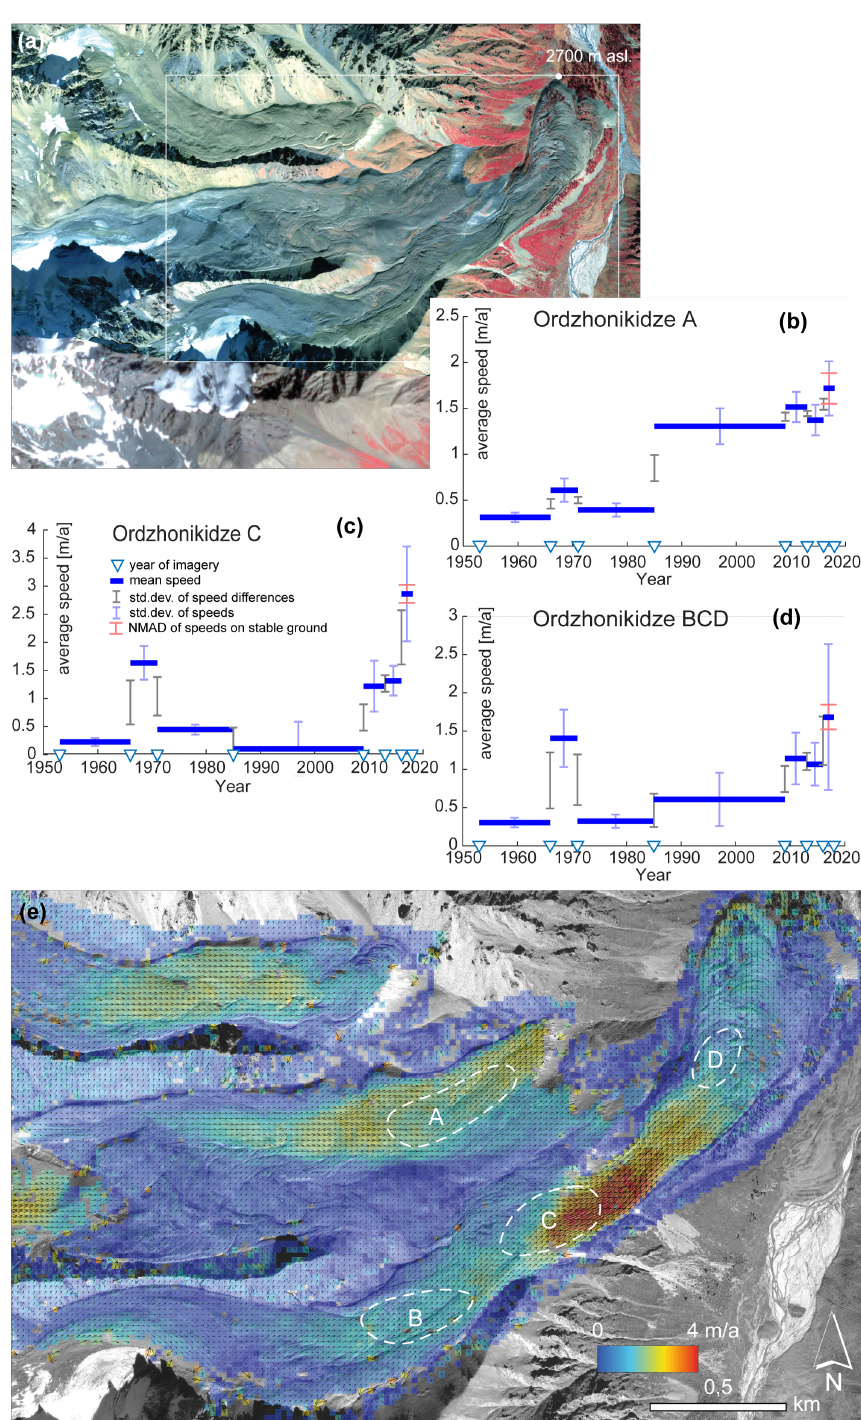
Figure 6. Velocities and speed variations across the Ordzhonikidze rock glacier system. (a) Overview image; GeoEye image (© Maxar) on 6 October 2013 in near-infrared false colour, with the southernmost part from a Planet image on 7 September 2016. (b–d) Average time series of speeds for clusters of points (zones A–D; white dashed outline in panel e ). Error bars give standard deviations of speeds within the point clusters (blue), standard deviations of speed differences within the measurement periods (grey), and the NMAD of stable ground offsets (red, 2016–2018 only) in m/a. Blue triangles on the time axis indicate years of imagery used. (e) Colour-coded velocity field with vectors superimposed from image matching between 2016 and 2018 high-resolution satellite images (for exact dates and sensors see Table S2). Background image: GeoEye, 6 October 2013 (©